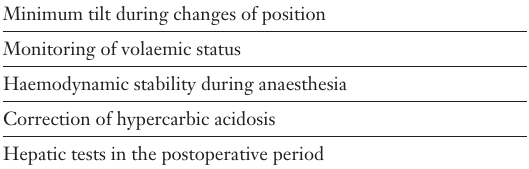
Clinical implications in high risk